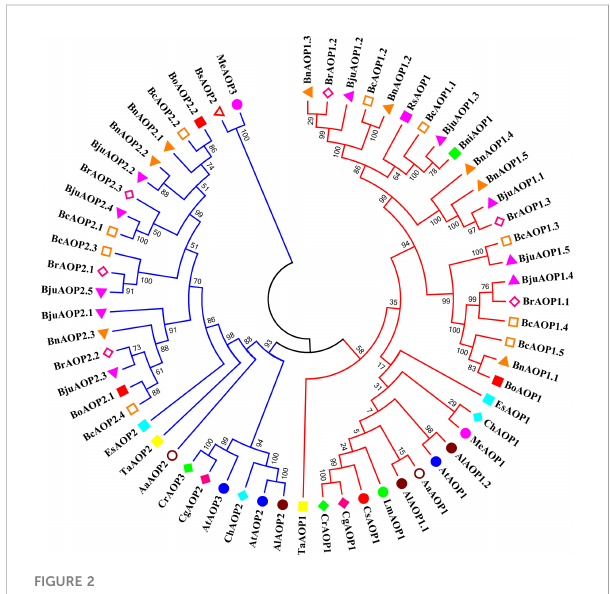
FIGURE 2 Phylogenetic tree of AOP genes from Brassicaceae species. The phylogenetic tree was built using the neighbor-joining (NJ) method. The unrooted tree was generated using Clustal W in MEGA11 via AOP amino acid sequences from 19 sequenced Brassicaceae species, including: Arabis alpina ( Aa. ), Arabidopsis lyrate ( Al. ), Arabidopsis thaliana ( At. ), Brassica carinata ( Bc. ), Brassica juncea ( Bju. ), Brassica napus ( Bn. ), Brassica nigra ( Bni. ), Brassica oleracea ( Bo. ), Brassica rapa ( Br. ), Boechera stricta ( Bs. ), Capsella grandi fl ora ( Cg. ), Cardamine hirsute ( Ch. ), Capsella rubella ( Cr. ), Eutrema salsugineum ( Es. ), Lepidium meyenii ( Lm. ), Microthlaspi erraticum ( Me. ), Raphanus sativus ( Rs. ), and Thlaspi arvense ( Ta. ). Genes from each species were labeled with different colors. The numbers at the nodes represent bootstrap percentage